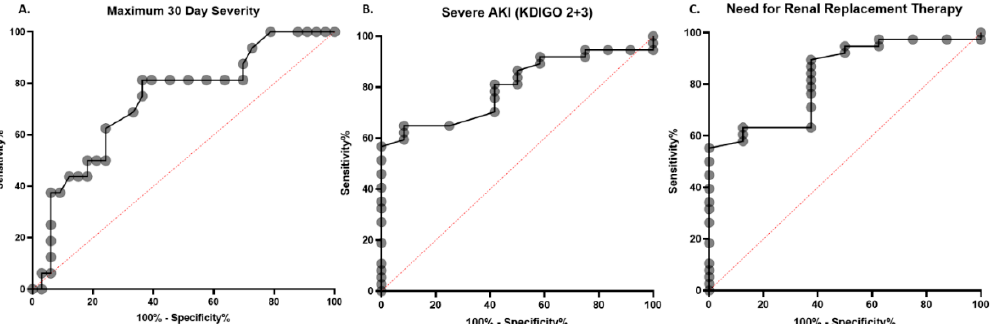
Figure 1. Receiver operating characteristics (ROC) curve of red blood cell distribution width (RDW) for the prediction of ( A ) progression to severe COVID-19 within 30 days of Emergency Department presentation (AUC: 0.73); ( B ) severe acute kidney injury (KDIGO 2 + 3) (AUC: 0.80); and ( C ) need for renal replacement therapy (AUC: 0.83). Dashed red line represents the line of non-discrimination.